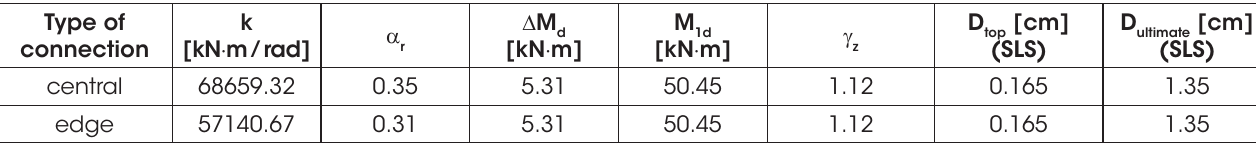
Verification of the optimal model Type